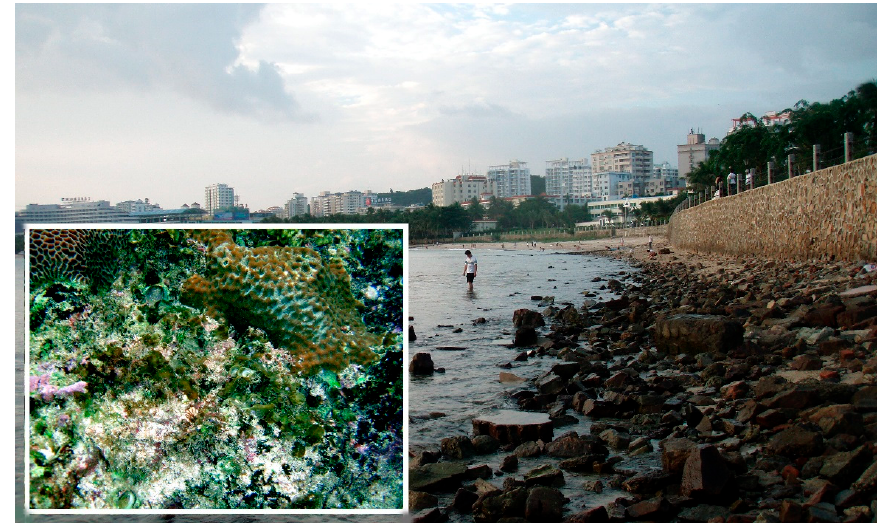
Figure 4. Dadong Hai at low tide, October 2008. Inset: Turf algae among live corals. The locality Yalong Wan (Xipai, a small rocky islet) was characterized by a sandy bottom with blocks of dead corals, stones, and boulders, and a rocky bottom near the islet; seaweeds were sampled in the intertidal and upper subtidal zones. At the locality Wenchang (Figure 5), algae were collected from the intertidal zone on a damaged coral reef. In Xian Hai, seaweeds were collected from beach cast and fishery nets, which were placed on the coral reef, poor in live corals.